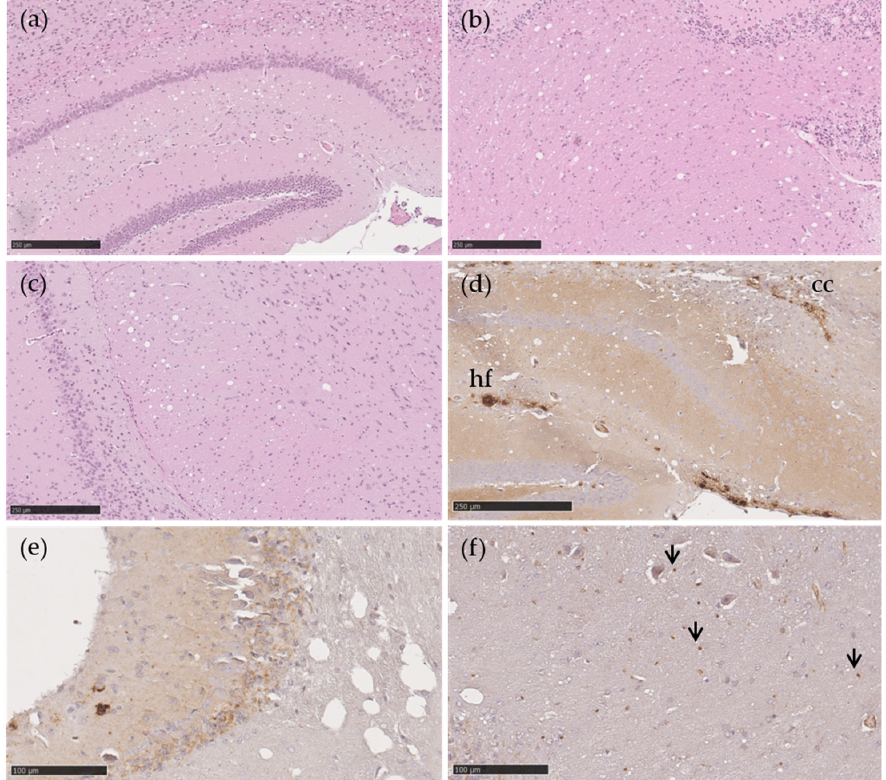
Figure 2. Vacuolation and PrP Sc in transgenic TgshpXI mice inoculated with Portuguese atypical scrapie AL 141 RR/AL 141 RR ( a – d ) and AL 141 RQ/AF 141 RQ ( e , f ) sheep isolates. Moderate vacuolation severity at the level of the hippocampus ( a ), cerebellar white matter ( b ) and cerebral peduncles ( c ). Aggregates and fine granular PrP Sc types in the hippocampus and corpus callosum ( d ) and in the molecular layer of the cerebellum ( e ). Punctate PrP Sc (arrow) in the white matter of the cerebellum ( f ). H&E ( a – c ), monoclonal 2G11 antibody ( d – f ). Scale bar = 250 µm ( a – d ), 100 µm ( e , f ). Abbreviations: cc, corpus callosum, hf, hippocampal fissure.